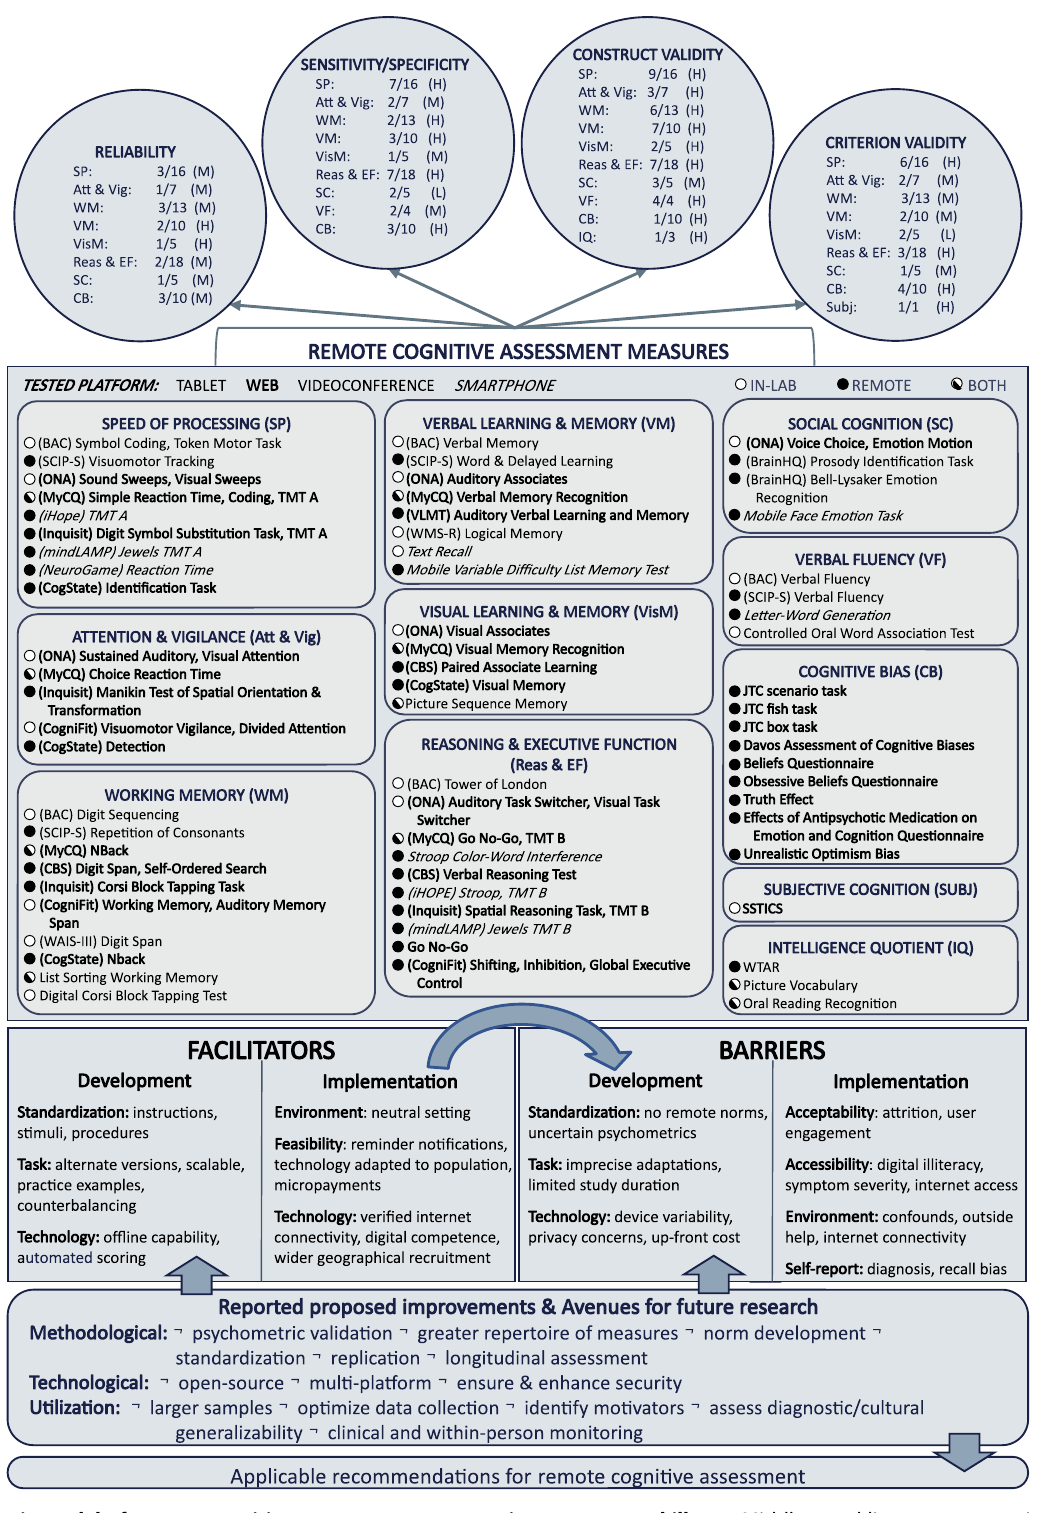
Fig. 2 Final logic model of remote cognitive assessment measures in severe mental illness. Middle panel lists remote cognitive measures, tested platform (tablet, web, videoconference, and/or smartphone), and study type (remote, in-lab, or both) per cognitive domain. Upper circles represent the number of measures per cognitive domain in which psychometric properties (reliability, sensitivity/speci fi city, construct/ criterion validity) were assessed over the number of measures assessing that domain. Adjacent letters summarize psychometric properties (low, L, moderate, M, high, H) detailed in Supplementary Data. Lower panels summarize facilitators, barriers, and avenues for future research, which are meant to guide future remote cognitive